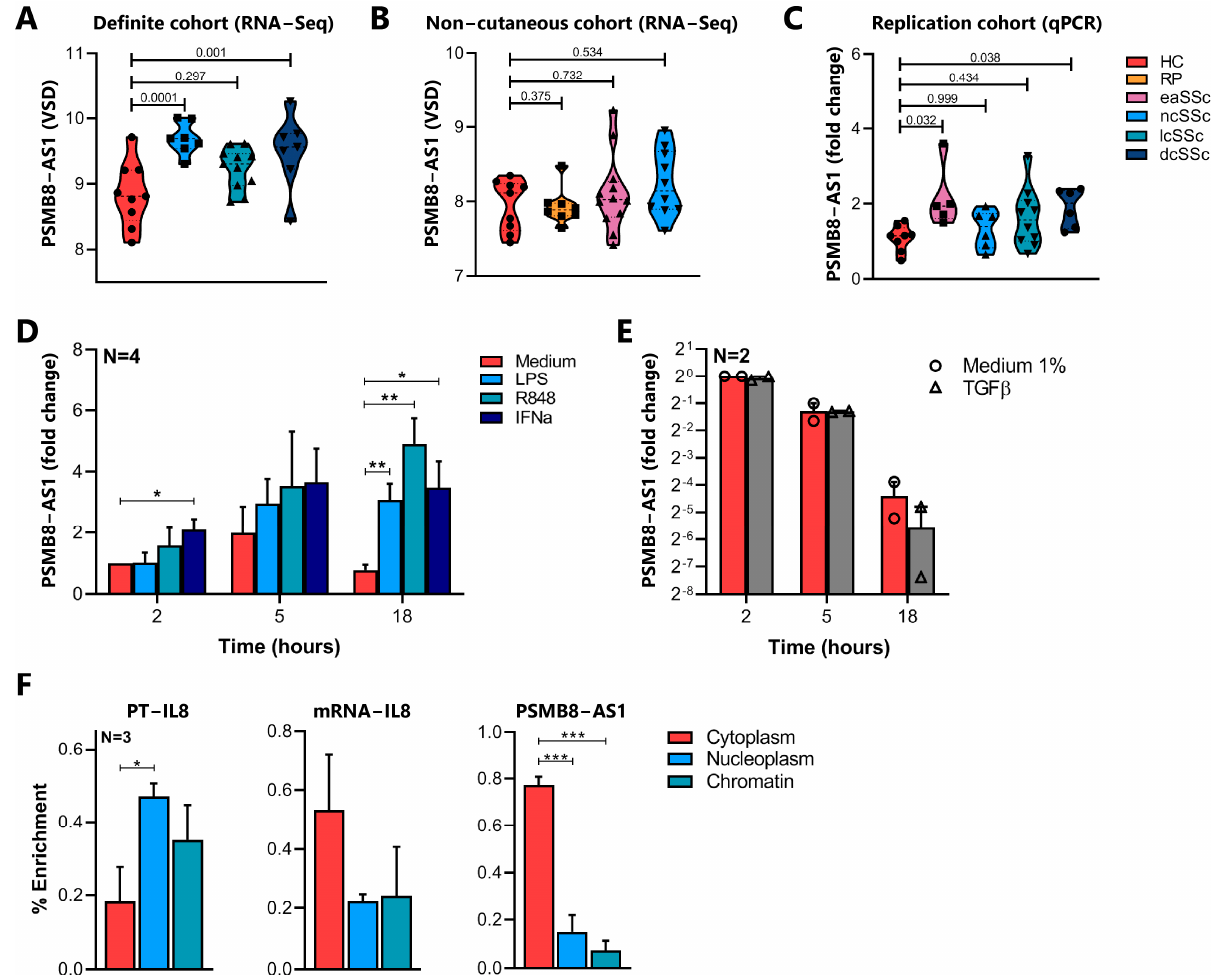
Figure 4. Molecular characterization of PSMB8-AS1 in healthy and SSc monocytes. PSMB8-AS1 expression in the ( A ) Definite cohort and ( B ) Non-cutaneous cohort assessed by RNA-Seq. Data are expressed as variance stabilized data (VSD), mean +/ − SEM is reported. For each comparison the p -value, calculated according to the Wald test, is shown. ( C ) PSMB8-AS1 expression was analyzed in the “Replication cohort” by RT-qPCR. Data are reported as the fold change of each donor versus one representative healthy control, and mean +/ − SEM is reported. p -values, as determined by the Kruskall–Wallis test with post-hoc Dunn’s test, are reported. ( D ) CD14+ monocytes were cultured for the indicated time points in the presence of LPS (100 ng/mL, light blue bars), R848 (5 µ M, green bars), IFN α -a2 (1000 U/mL, dark blue bars), or ( E ) TGF β (0.01 ng/ µ